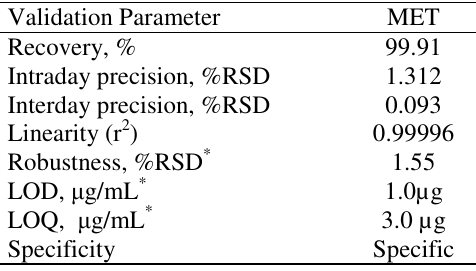
Table 2. Analytical method validation